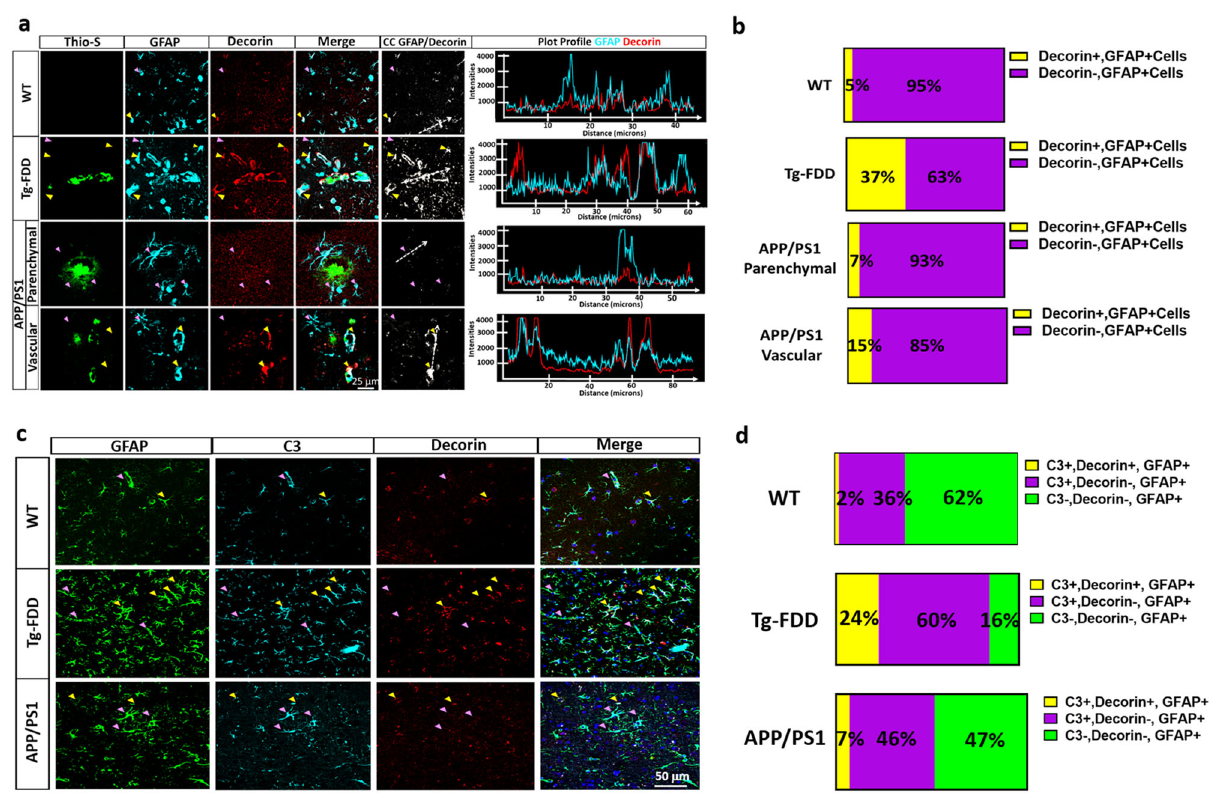
Fig. 6 Decorin + astrocytes are associated with vascular amyloid in vivo. a Triple immuno fl uorescence of amyloid (Thio-S, green), astrocytes (GFAP, cyan), and Decorin (red) in the cortex of 15-month-old Tg-FDD, APP/PS1 mice and WT controls. Major presence of Decorin immunoreactivity is observed in the perivascular region of Thio-S positive vasculature in Tg-FDD mice. Yellow arrows indicate Decorin + , GFAP + cells and purple arrows indicate Decorin-, GFAP + cells. Colocalization analysis (CC) was performed to determine pixel intensity correlation between GFAP and Decorin. White pixels indicate colocalization between GFAP and Decorin signal and white dashed arrows represent distance in plot pro fi les showing overlapping intensities of astrocytes (GFAP, cyan) and Decorin (red). b Quanti fi cation of the proportion of Decorin + cells in Tg-FDD, APP/PS1 and WT mice. c Triple immuno fl uorescence of astrocytes (GFAP, green), complement component 3 (C3, cyan), and Decorin (red) in the cortex of 15-month-old Tg-FDD and APP/PS1 mice. Yellow arrows indicate C3 + , Decorin + , GFAP + cells and purple arrows indicate C3 + , Decorin-, GFAP + cells. d Quanti fi cation of the proportion of C3 + Decorin + astrocytes versus C3 + astrocytes in Tg-FDD, APP/PS1 and WT mice. For quanti fi cations, eight to ten images were used for each experiment ( n = 3), and 200 cells were counted. All are representative images of 15-month-old Tg-FDD, APP/PS1 or WT mice. Scale bar 25 or 50 μ m,